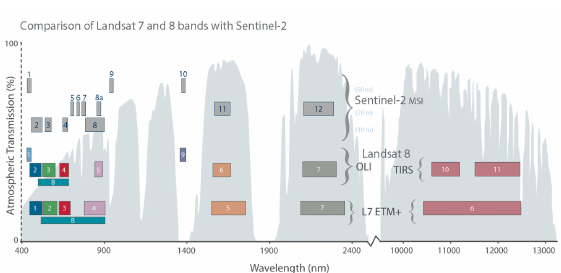
Figure 3. Comparison of Sentinel-2 with Landsat 7 and 8 (source: